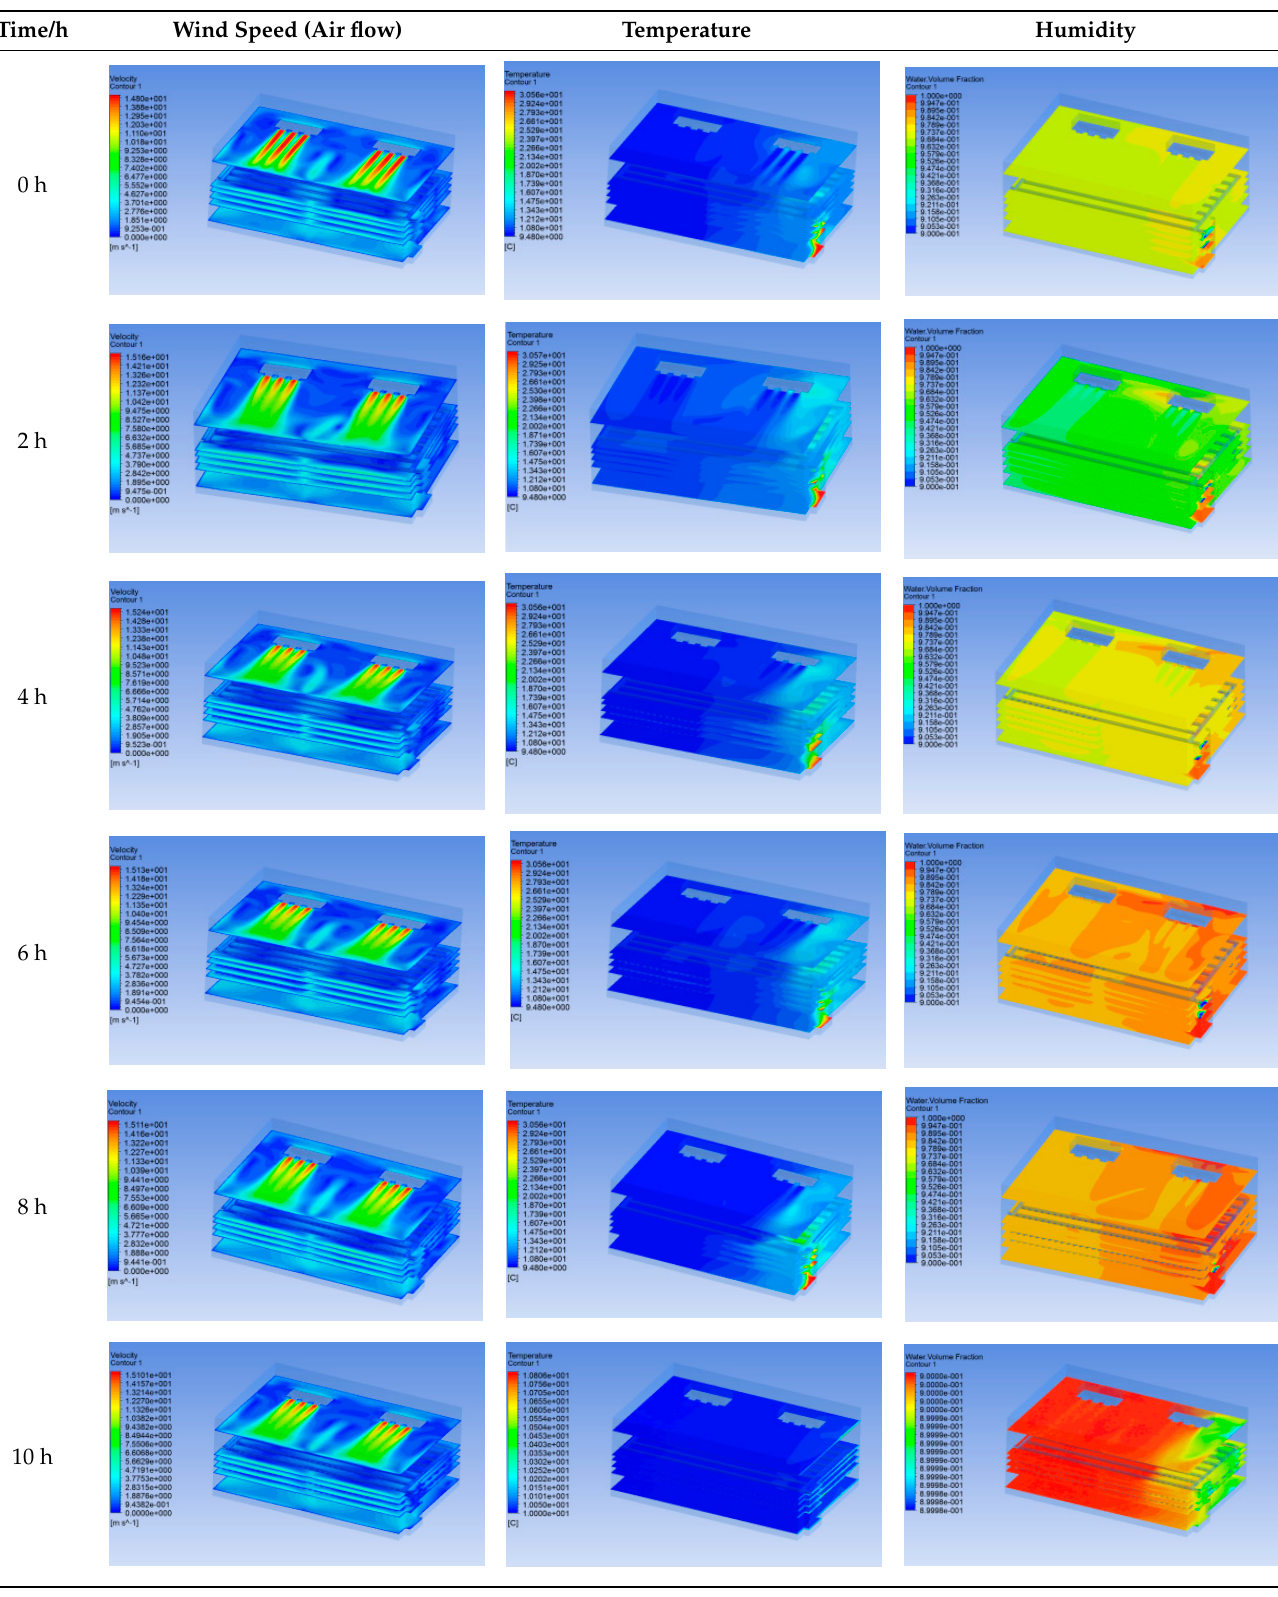
Table 3. Fluid simulation of wind speed, temperature, and humidity in a chiller.